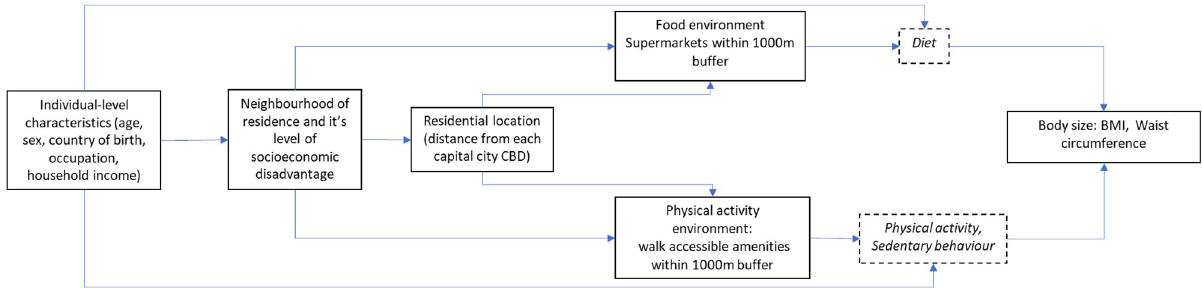
Fig 1. Directed Acyclic Graph (DAG) depicting relationships between neighbourhood socioeconomic disadvantage, obesogenic environments, and body size (body mass index and waist circumference). Variables included in analyses are denoted by boxes with solid outlines. Boxes with dashed lines and italic text represent untested variables and are included in the DAG for